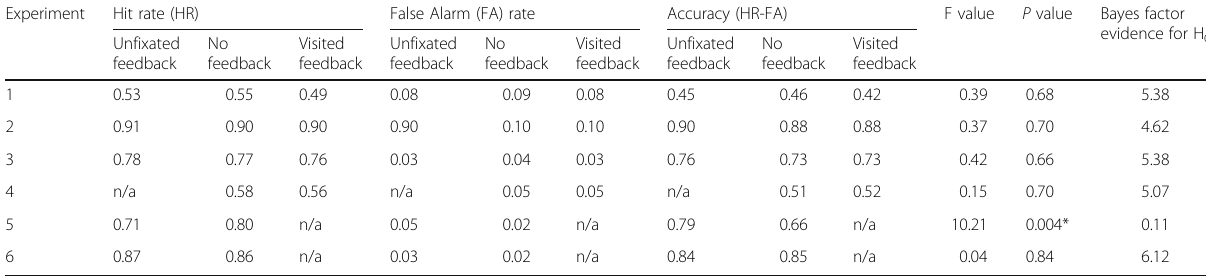
Table 2 Behavioral performance and associated statistics